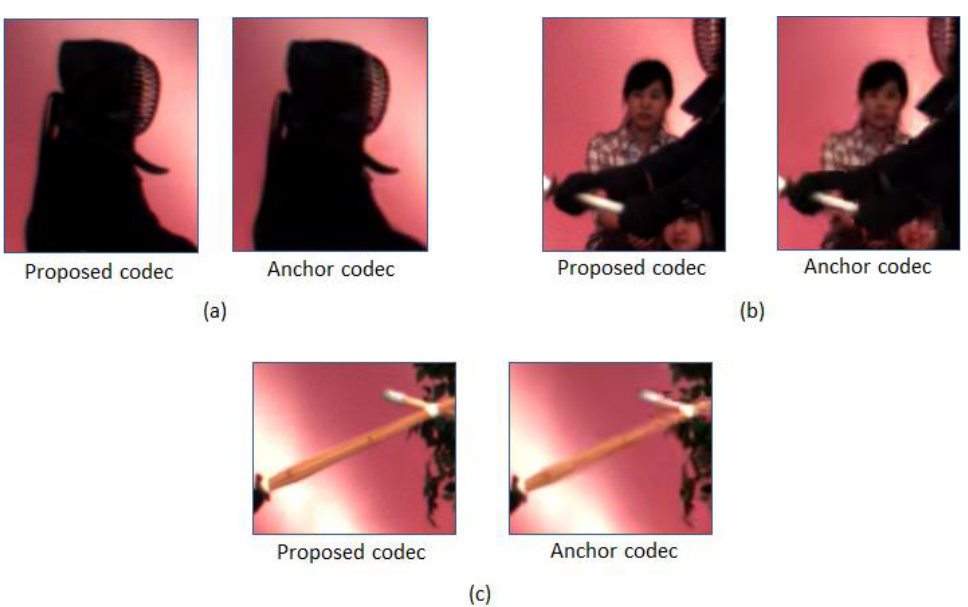
Figure 8. Snippets of the highlighted areas of the proposed and the anchor codecs from Figure 7a,b respectively, ( a ) kendo artist’s mask’s details ( b ) edges of the girl’s head and facial details and ( c ) edge details in moving object.